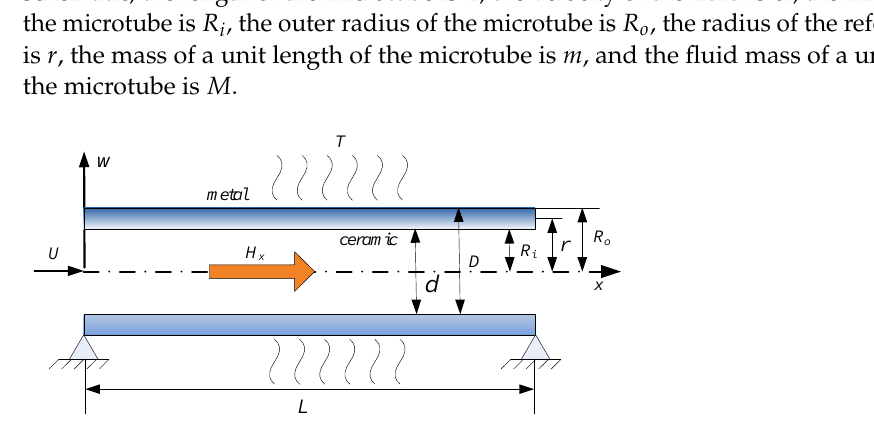
Figure 1. Schematic of the functionally graded, simply support, fluid-conveying microtube under multiple physical fields.